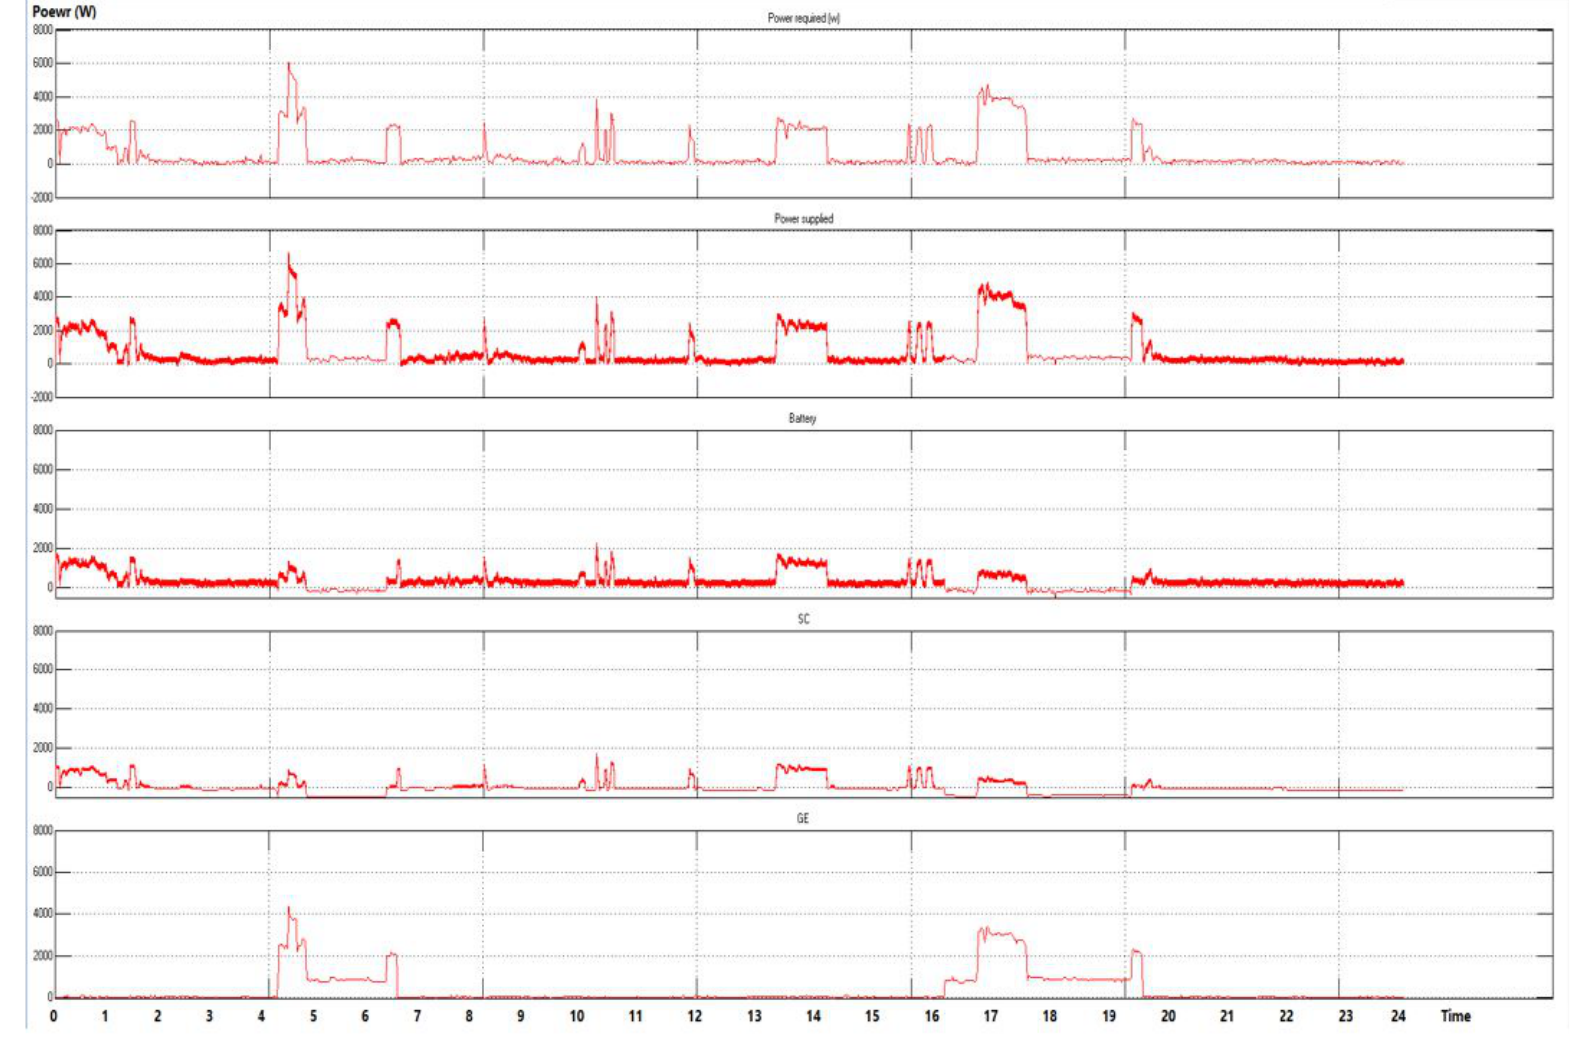
Figure 5. Summer day simulation